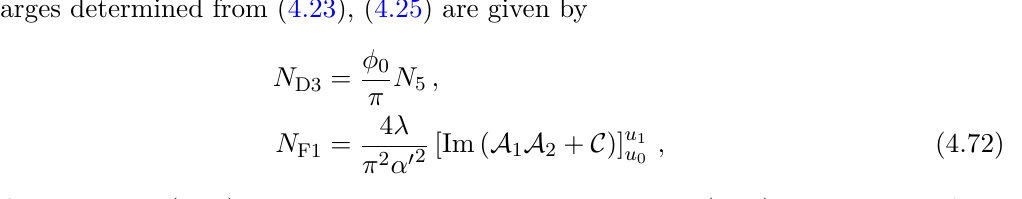
, 1 , 1 } from left to right. For K/N 5 < 1 4 2